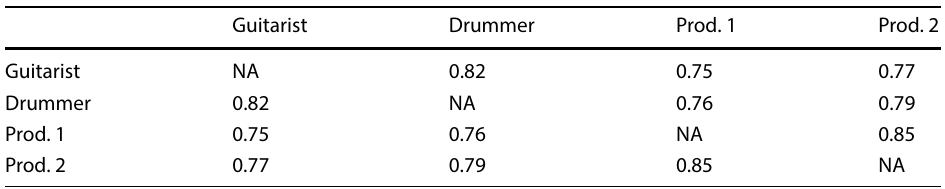
Table 1 Pearson’s correlation matrix for all 4